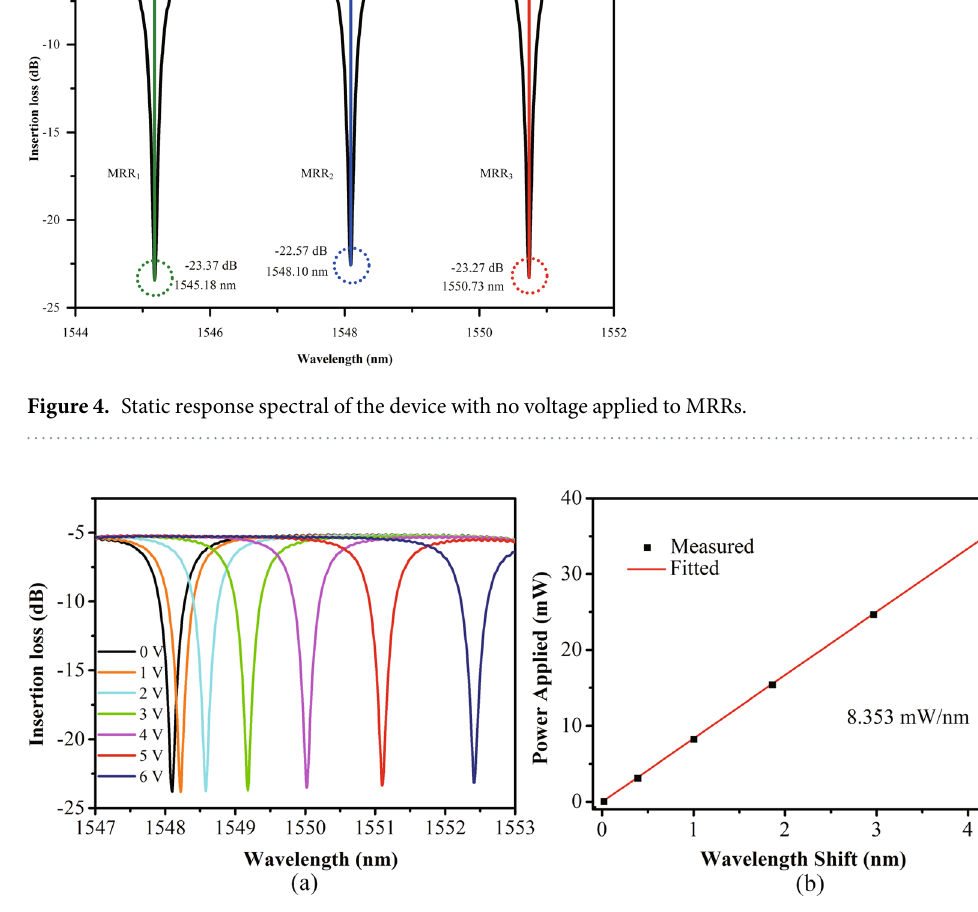
Figure 5. ( a ) Resonance shift of the MRR with different driving voltages, as well as ( b ) the tuning efficiency of the